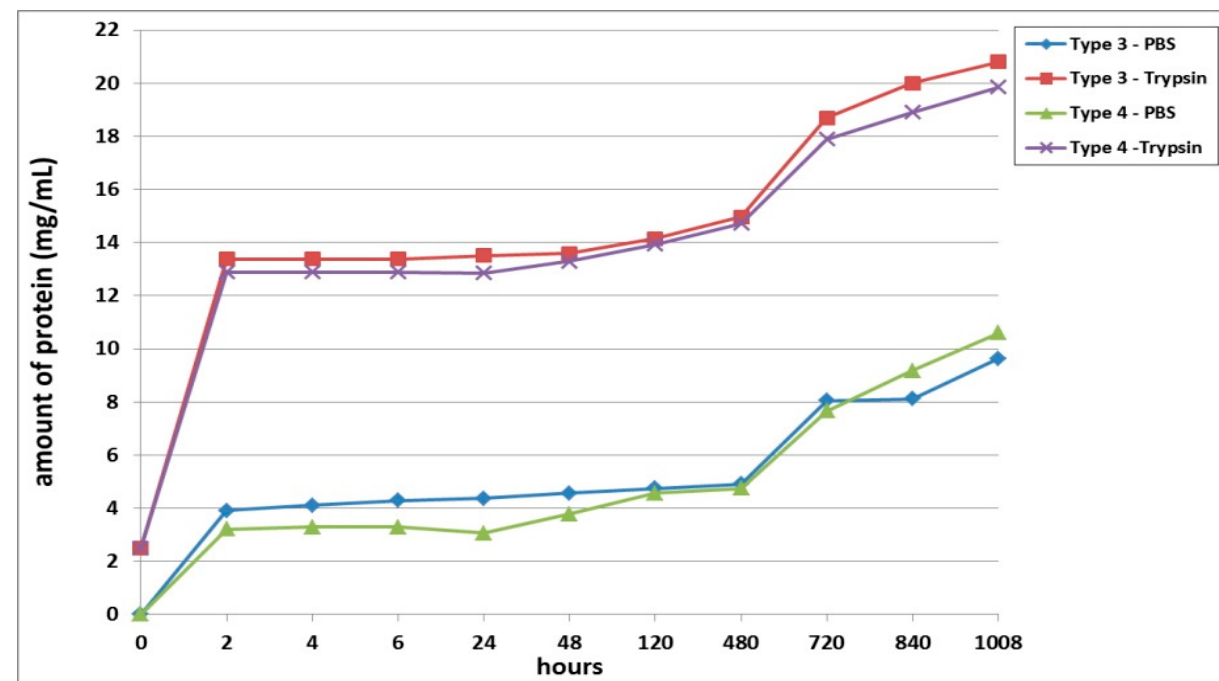
Figure 2. Biodegradation of scaffolds with encapsulated ASCs pre-cultivated for 24 h prior the analysis. Note: PBS—passive biodegradation of scaffolds in PBS solution; Trypsin—enzymatic biodegradation of scaffolds in a solution of the hydrolytic enzyme trypsin.